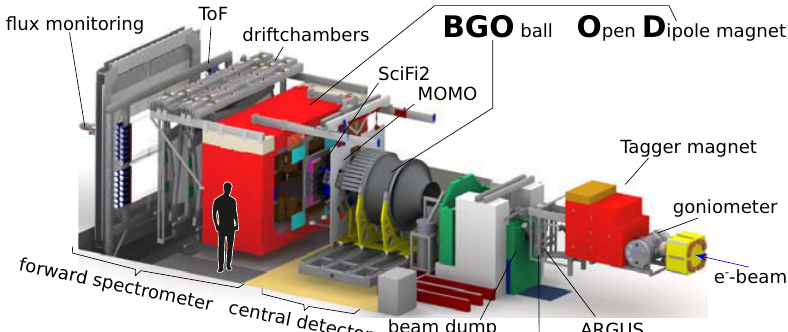
Figure 3. The BGO-OD setup.